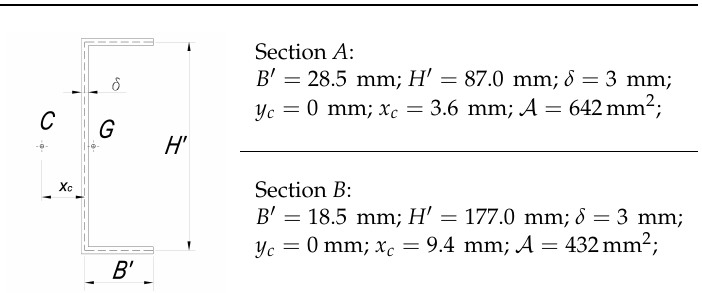
Table 2. Mechanical proprieties of S 420 steel-grade.